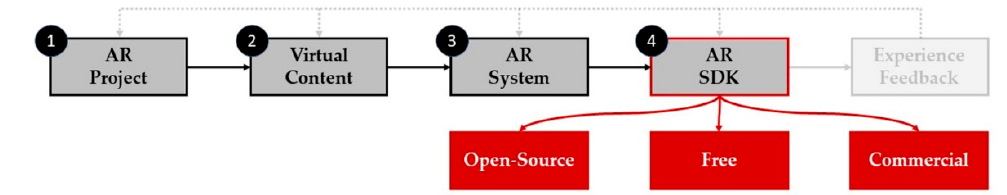
Figure 13. Block diagram of the main features of the AR-SDKs.